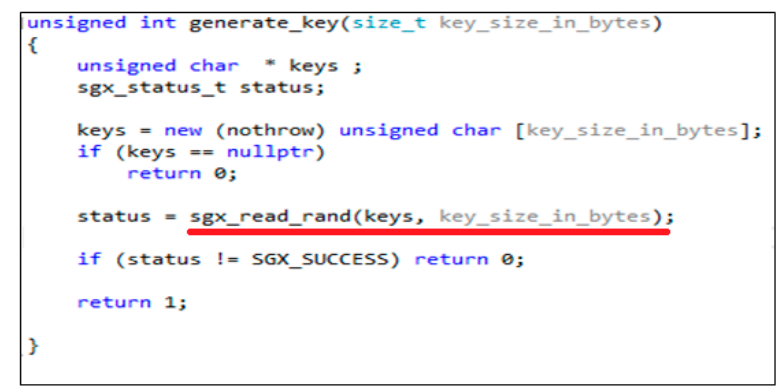
Figure 8. The code for generating the Encryption Key.